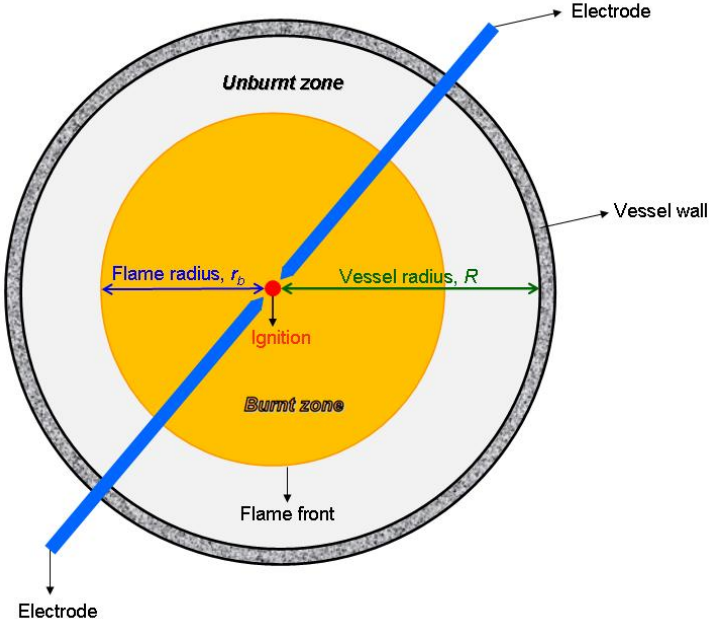
Figure 2. Flame front development in the spherical explosion bomb (equatorial view). A representative diagram of pressure variation into the experimental bomb during the explosion of stoichiometric CH 4 -N 2 O mixture diluted with 60% N 2 , at p 0 = 1.50 bar and ambient initial temperature is presented in Figure 3, together with the transient signal of the ionization gauge (U IP ) and the rate of pressure rise (d p /d t ). In this diagram, the incipient (early) stage of the explosion defined by restriction ∆ p = p 0 = 1.50 bar was also indicated. As can be seen, the incipient period of flame propagation is much smaller than the time necessary to achieve the maximum rate of pressure rise (in the present research, 53.7 ms) when the heat losses become